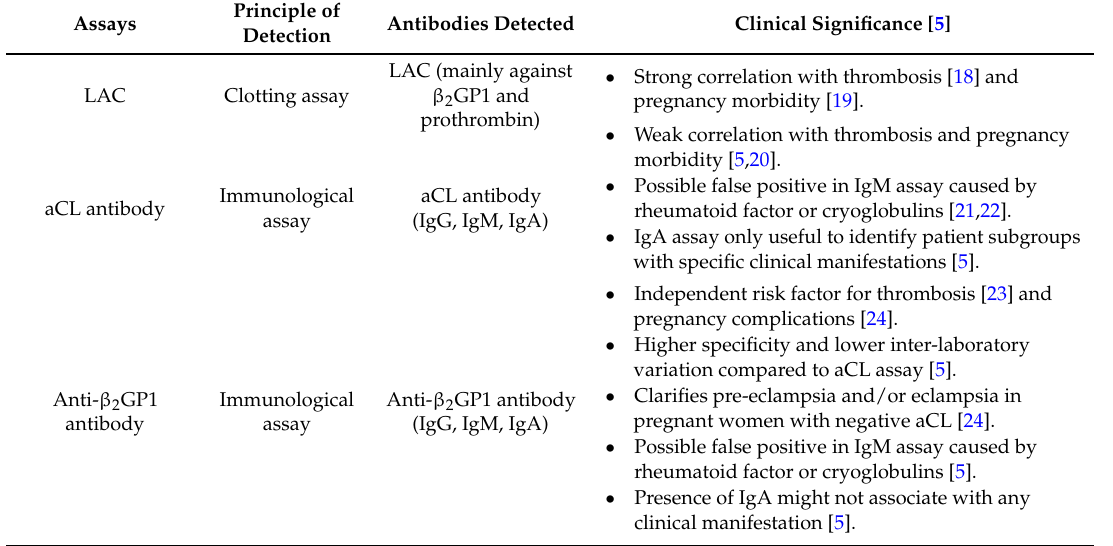
Table 1. Detection of anti-phospholipid antibodies and their clinical